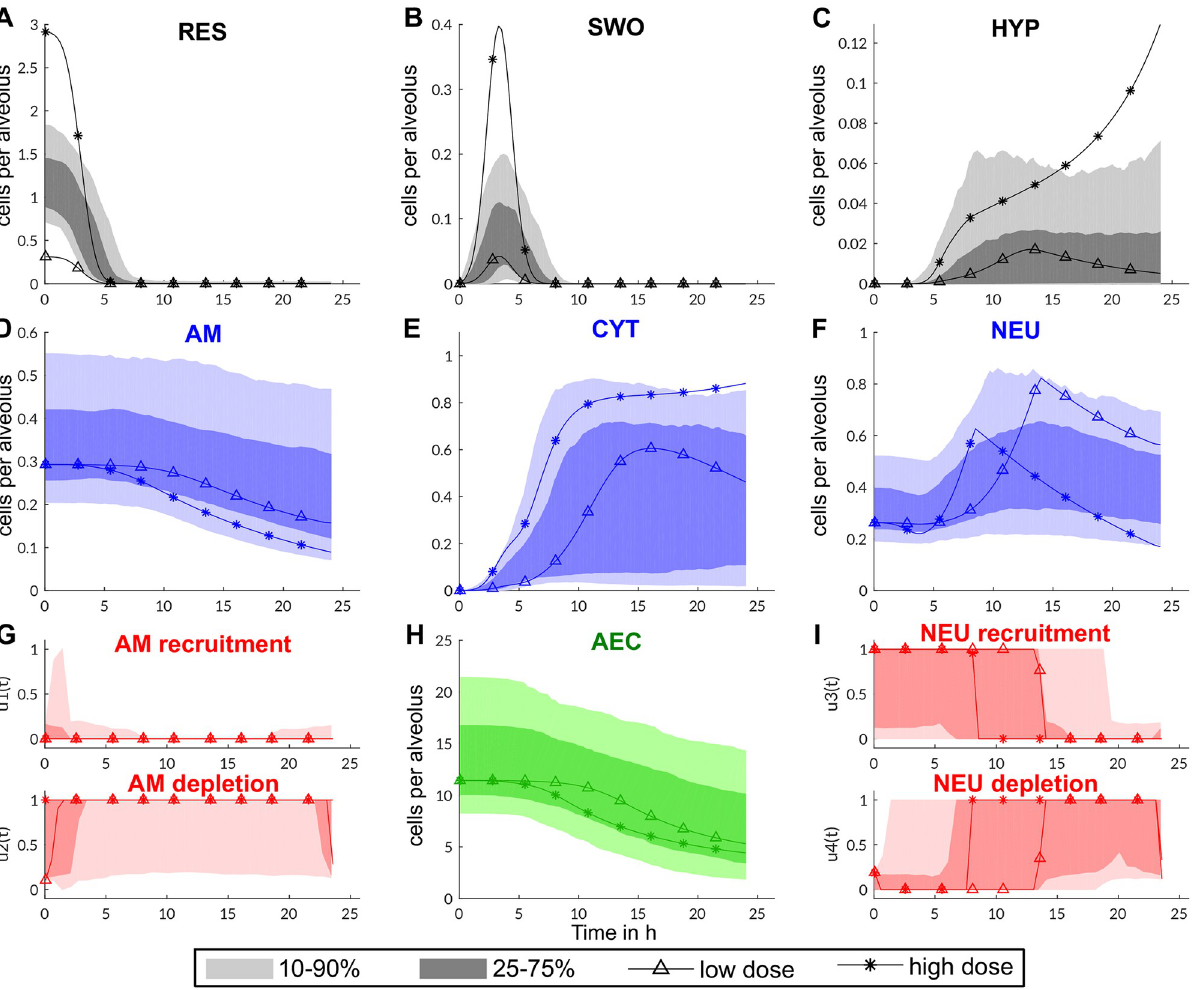
Fig 2. Dynamics of innate immune response of the murine host for varying parameters (shadings) and two dose scenarios of conidia based on the reference parameter set (lines). A-C Dynamics of fungal cells per alveolus. D, F show the dynamics of the immune cells per alveolus which are influenced by the optimized recruitment and depletion rates in panels G and I (rates between 1, maximal, and 0, no recruitment/depletion). Recruitment and depletion potential is dependent on the cytokine level ( E ). Cytokines are produced by alveolar macrophages ( D ) and alveolar epithelial cells ( H ) in response to swollen conidia ( B ) or hyphae ( C ). The simulations of 500 parameter sets are depicted with shadings indicating the confidence intervals of time